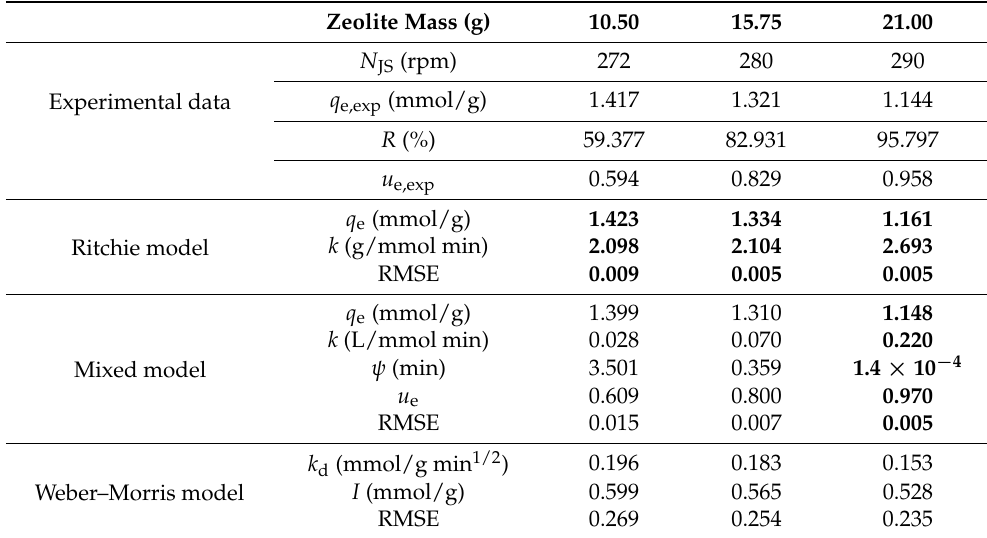
Table 2. Estimated kinetic model parameters and statistical indicators of agreement of all the models used with the experimental data for various mass of zeolite.